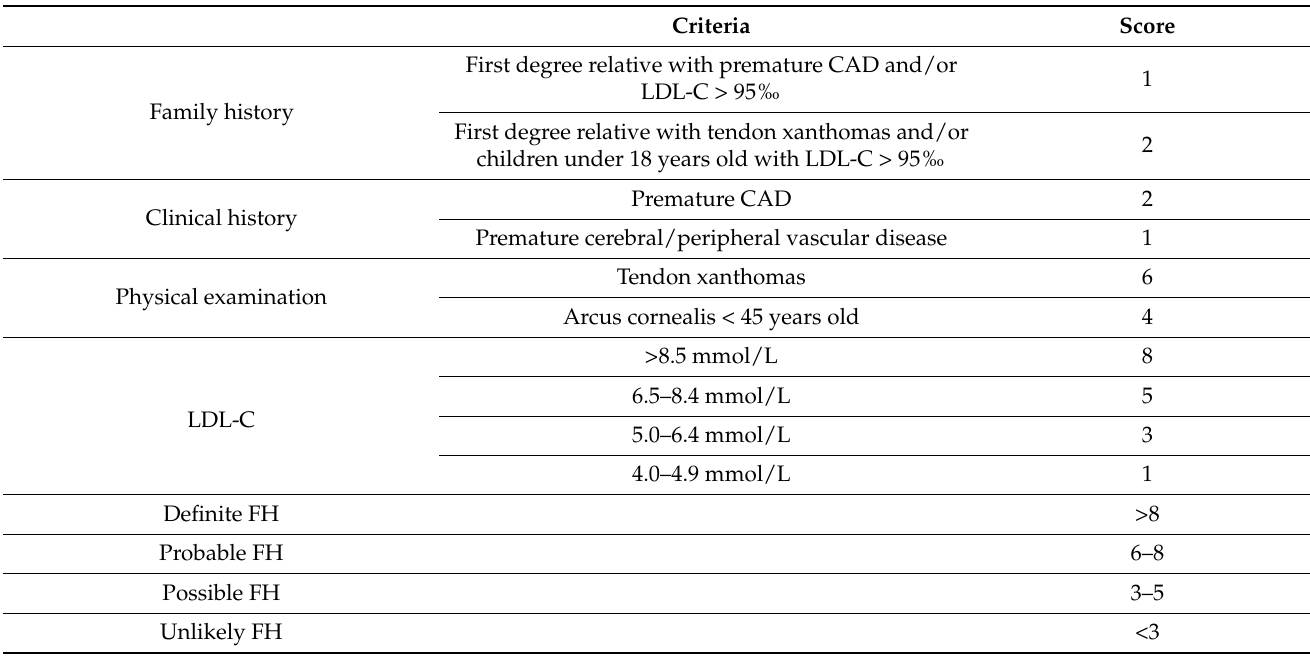
Table 1. The Dutch Lipid Clinic Diagnostic Criteria for FH detection. Adapted with permission from Ref. [33]. 2004 Sept, Melissa A. Austin et